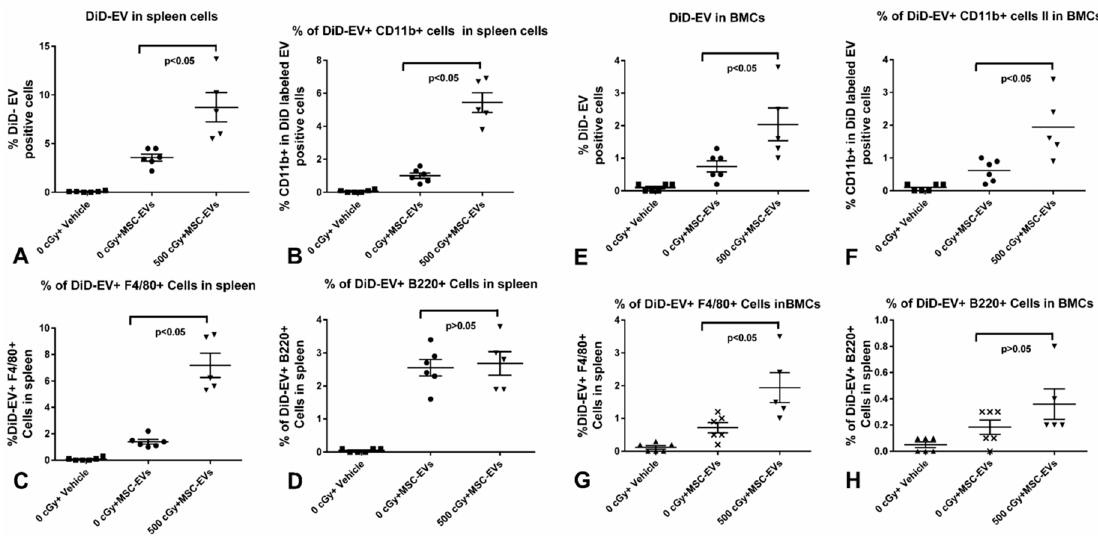
Figure 4. MSC-EV uptake in different immune cells determined by flow cytometry. The alteration of MSC-EV uptake in spleen ( A ) and bone marrow ( E ) from mice post radiation exposure . The alteration of MSC-EV uptake by CD11b+ cells in the spleen ( B ) and marrow ( F ), F4/80+ cells in the spleen ( C ) and bone marrow ( G ), and B220+ cells in spleen ( D ) and marrow ( H ) from mice post radiation exposure. n = 5 or 6/group. The one-way ANOVA with multiple comparisons test was used as statistical